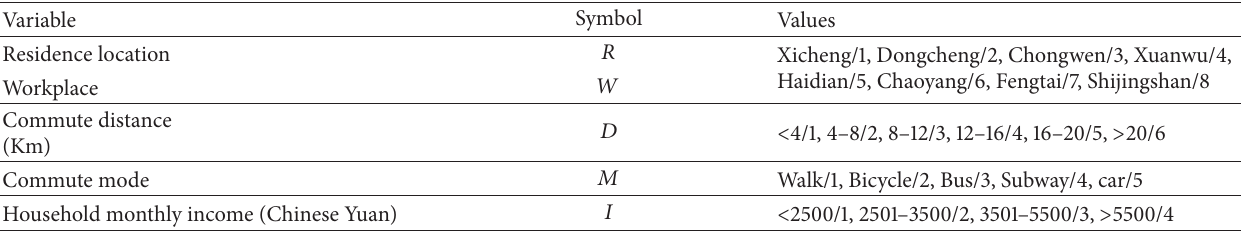
Table 1: Variables in the latent class